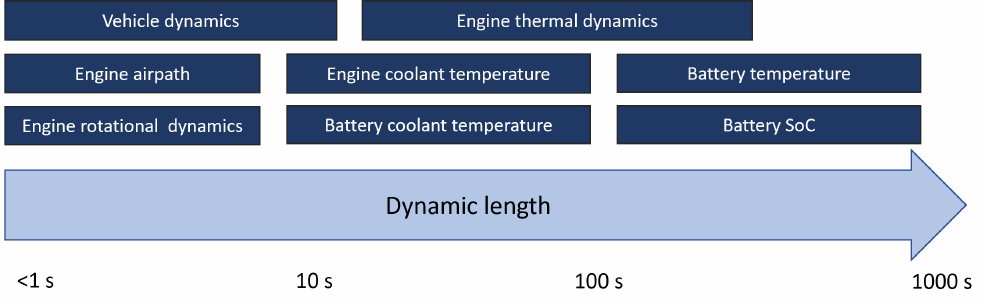
Figure 10. Characteristic times of various powertrain systems and